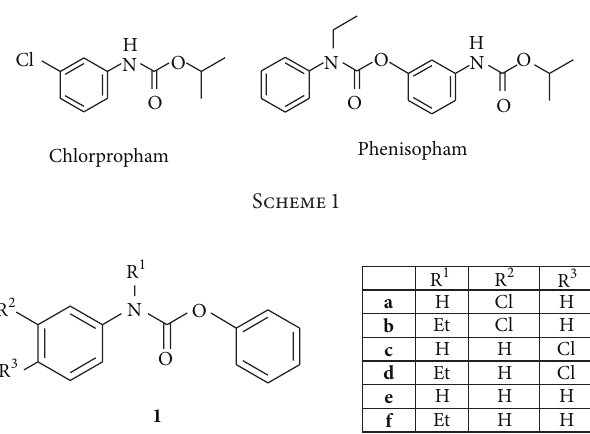
Figure 1: Synthetic carbamates